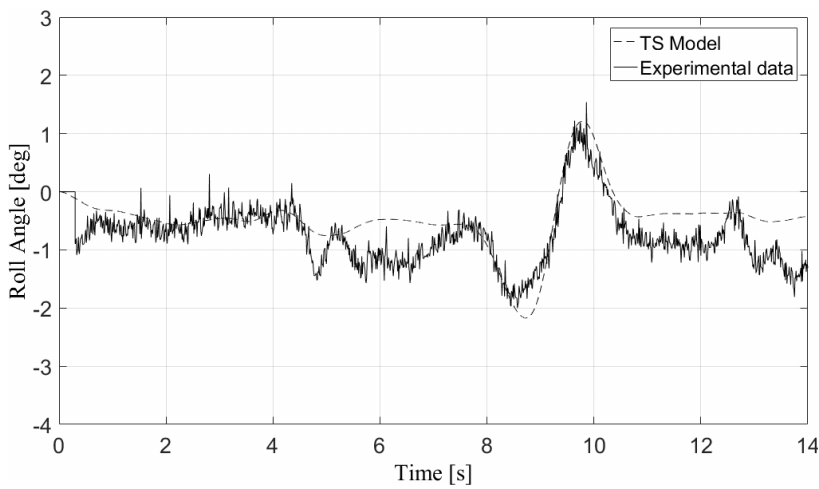
Figure 4. Validation of the vehicle simulation model for a change lane maneuver.